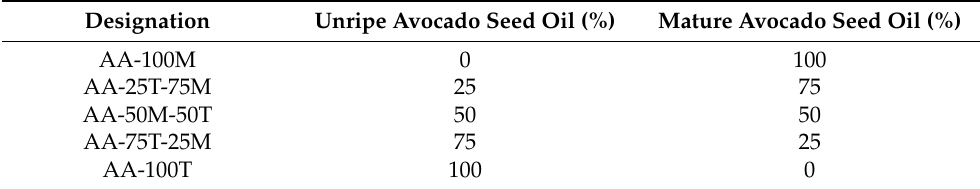
Table 1. Nomenclature of the combinations of unripe and mature avocado seed